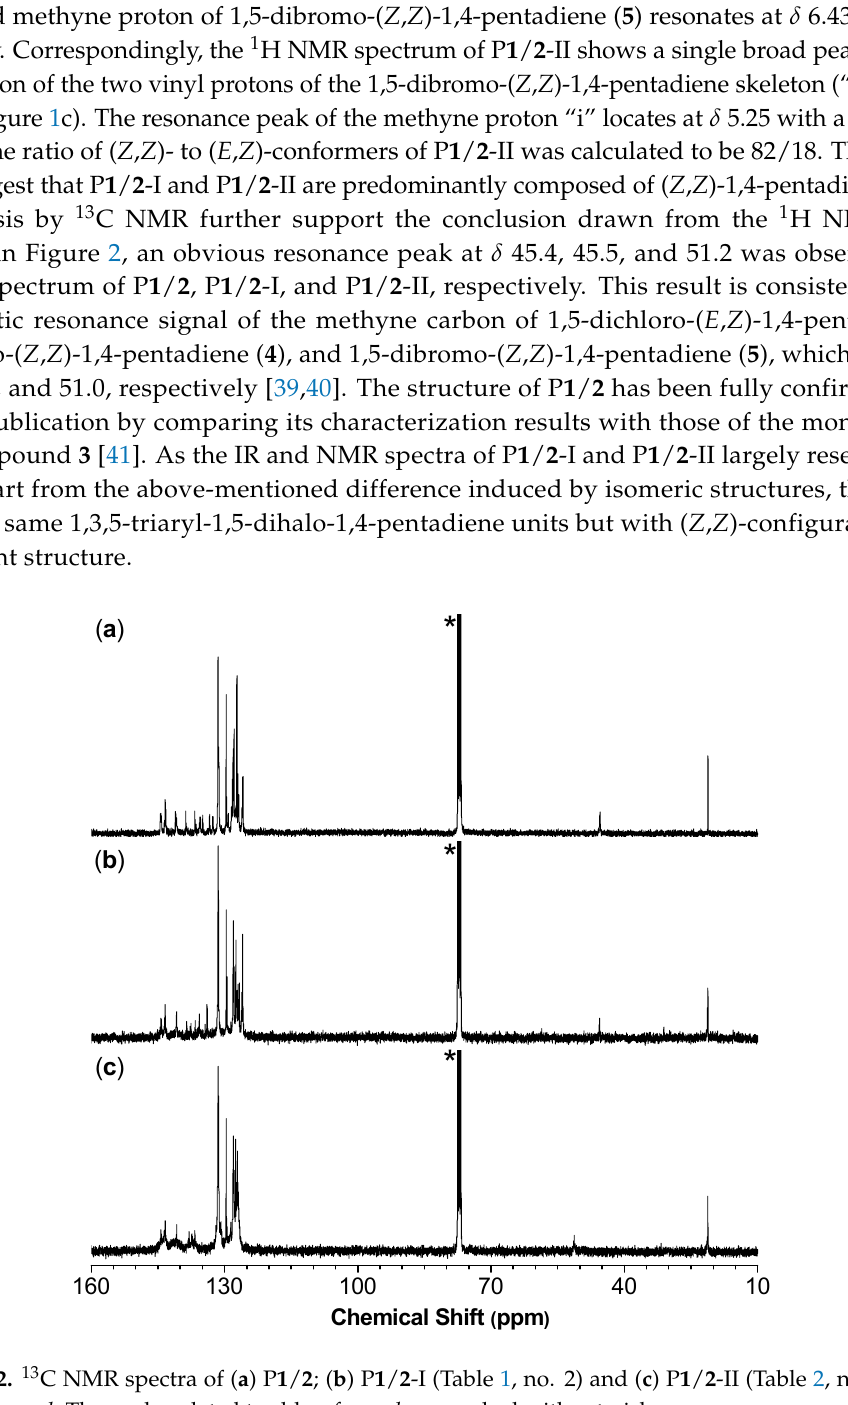
Figure 1. 1 H NMR spectra of ( a ) P 1 / 2 ; ( b ) P 1 / 2 -I (Table 1, no. 2) and ( c ) P 1 / 2 -II (Table 2, no. 3) in